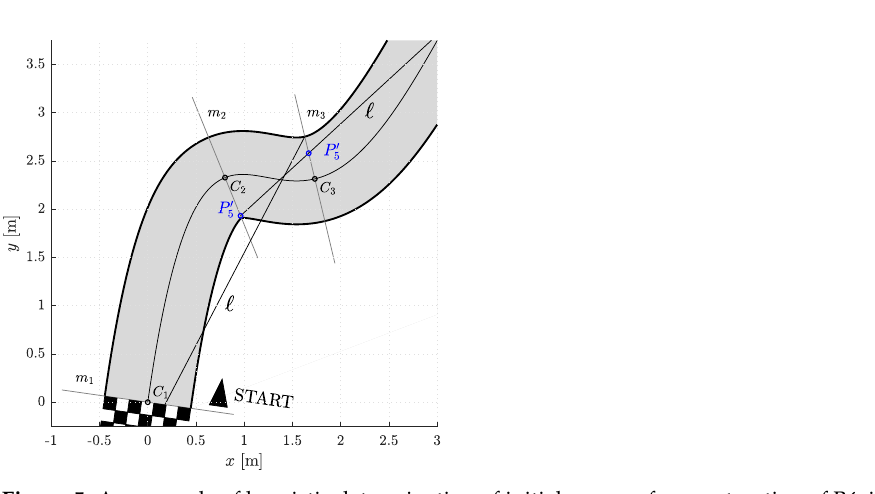
Figure 5. An example of heuristic determination of initial guesses for construction of Bézier